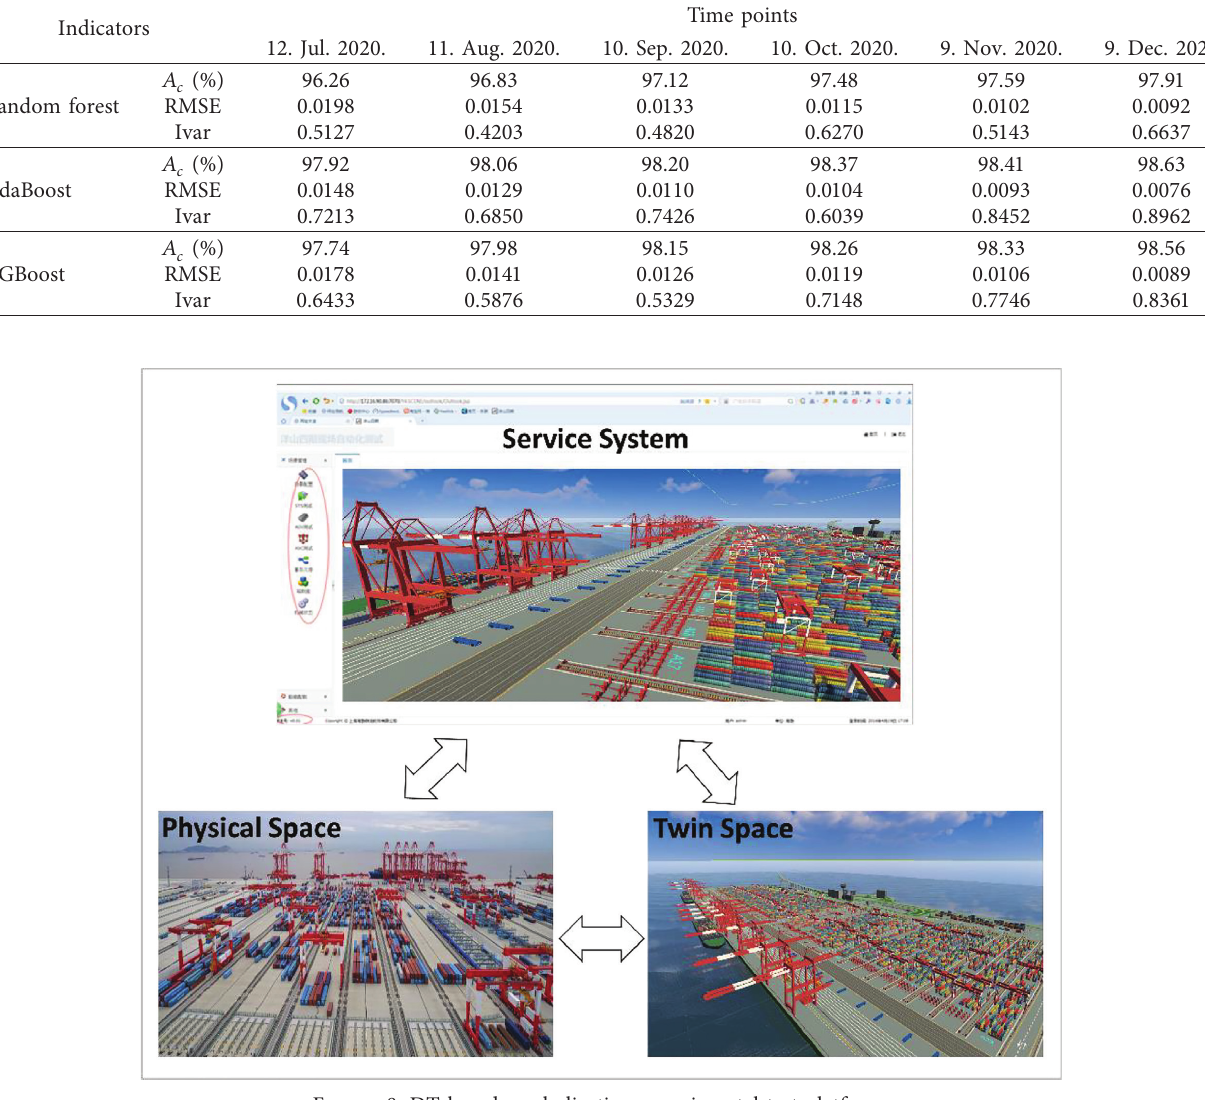
Figure 8: DT-based symbolization experimental test platform.